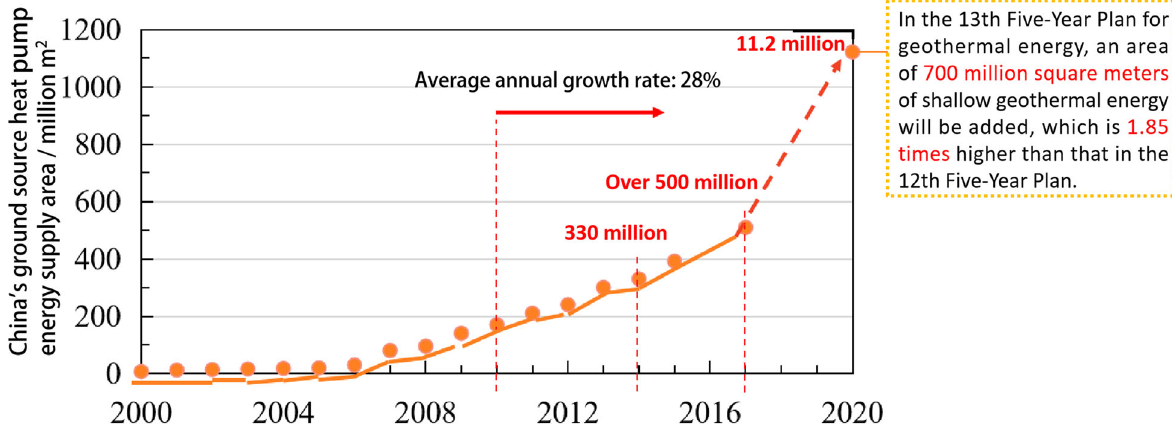
Fig. 4 Annual variation of energy supply area of GSHPs in China